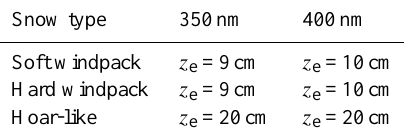
Table D1. e-folding depths measured in snowpacks at Dome C from France et al. (2011) (adapted from Fig. 1).